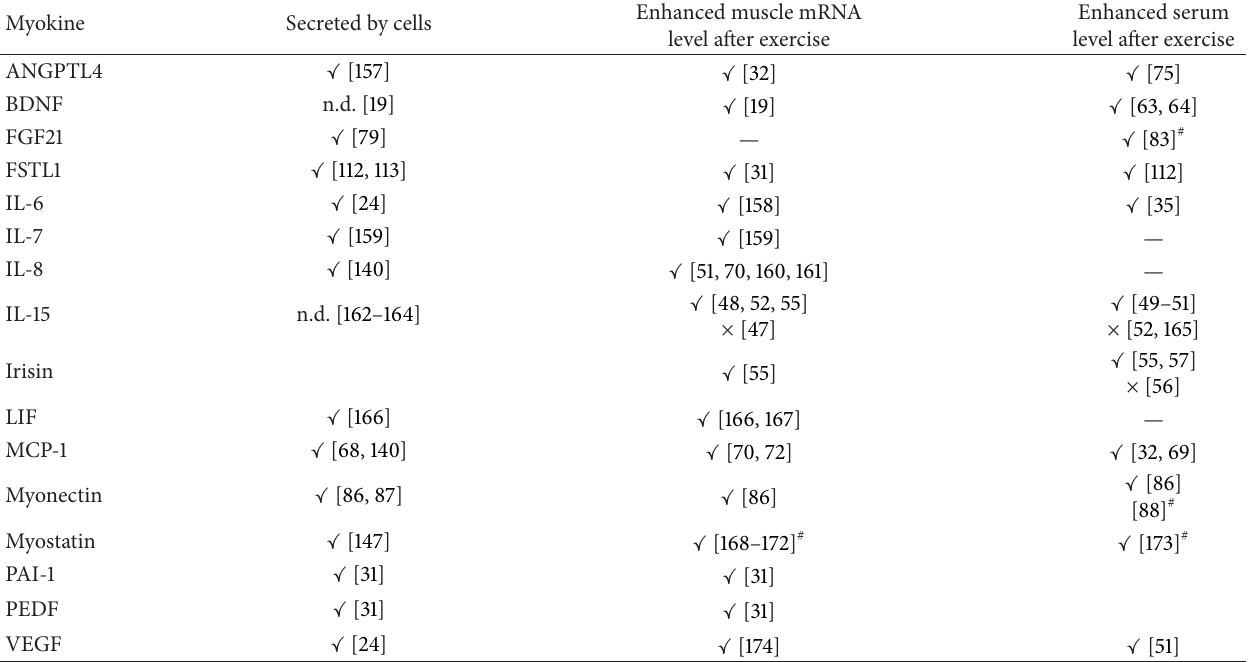
Table 1: Contraction-regulated myokines. A search of original articles in pubMed was performed for all myokines described to identify contraction regulation of a myokine on the level of enhanced muscle mRNA expression and enhanced serum level. In addition, studies describing basal secretion of the indicated myokine from myotubes ( in vitro studies) are given. The search terms used were “skeletal muscle,” “myokine,” “exercise,” “secretion,” and the indicated myokine. Reference lists of identified articles were also used to search for further papers.